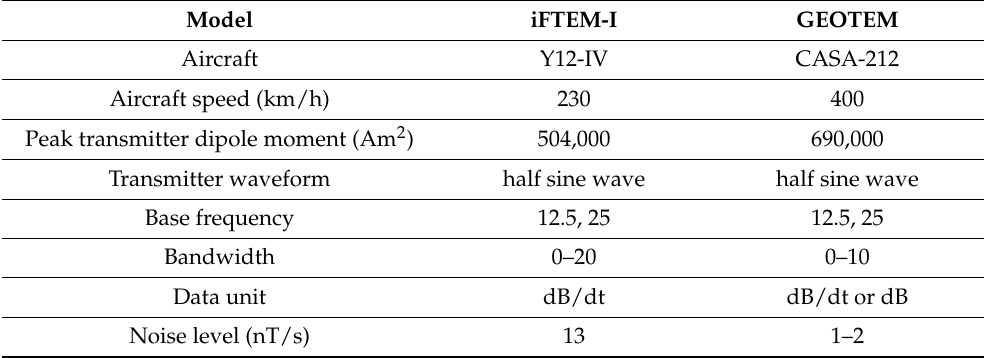
Table 1. Comparison between iFTEM-I and GEOTEM. Model iFTEM-I GEOTEM